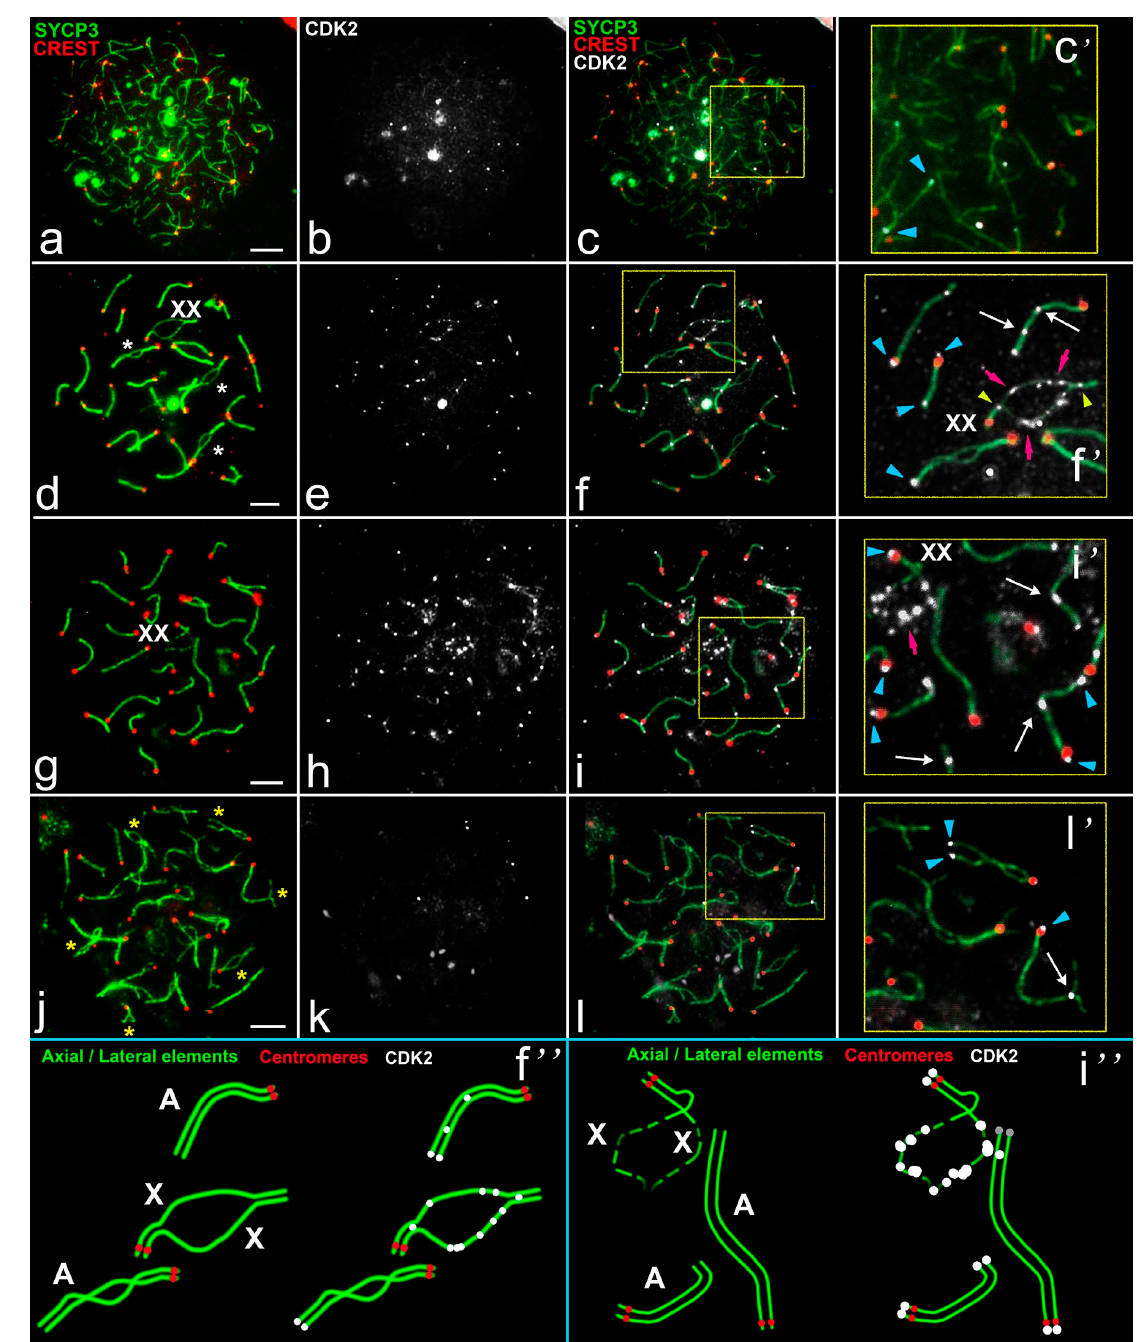
Figure 3. Cdk2 localization in meiotic chromosomes of spermatocytes of the mole vole E. talpinus . SCs were immunostained using antibodies to SYCP3 protein (green), centromeres using antibodies to proteins of kinetochores (CREST, red), and kinase CDK2 using antibodies to CDK2 (white). Blue arrowheads point to the telomeric CDK2 localization. White arrows pointed to the interstitial CDK2 localization. Pink arrows outline numerous CDK2 signals in asynaptic segments of the sex bivalent. a–c. Late leptotene—early zygotene. d–f. Late zygotene—early pachytene. White stars mark asynaptic regions in the bivalents. Yellow arrowheads point to two CDK2 signals in the synaptic segments in the sex bivalent. g–i. Mid pachytene. j–l. Diplotene. Desynapsis in several bivalents was marked as yellow stars. c ʼ , f ʼ , i ʼ , l ʼ - enlarged parts of the relevant photos. f ʼʼ , i ʼʼ - schemes of meiotic chromosomes in f ʼ , i ʼ . Scale bar ( а –l) = 5 µm.